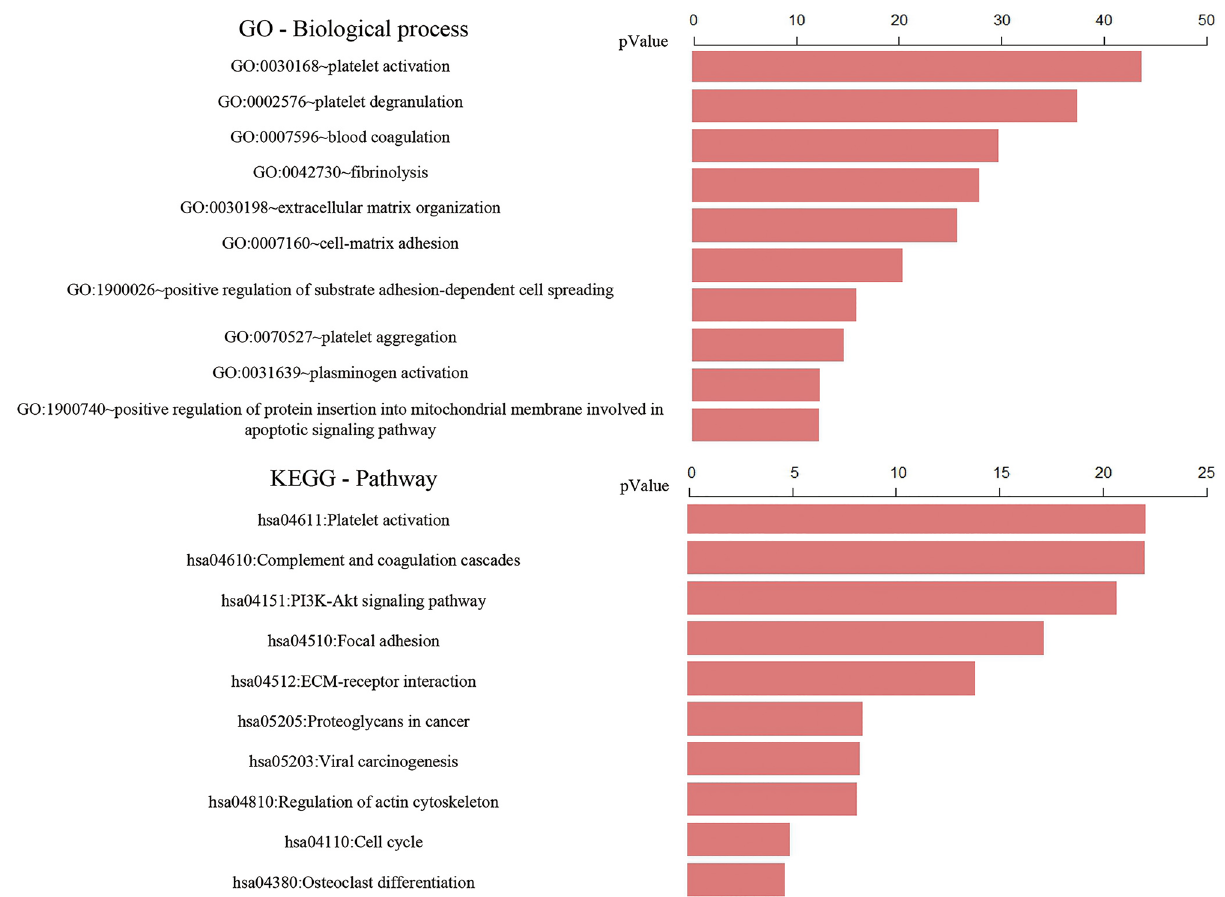
Figure 3. GO biological process and KEGG signaling pathway. top: GO biological process; bottom: KEGG signaling